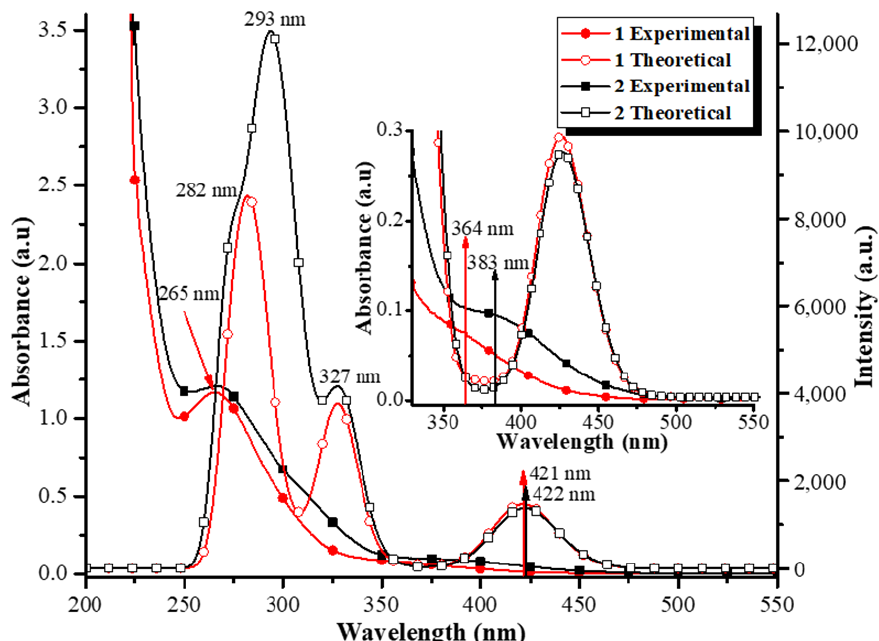
Figure 5. Comparison of the calculated and experimental absorption spectra in EtOH solution (6.0 (6.0 × 10 − 5 M) for 1 and 2 . Inset: amplified visible region of the absorption × 10 −5 M) for 1 and 2 . Inset: amplified visible region of the absorption spectra.